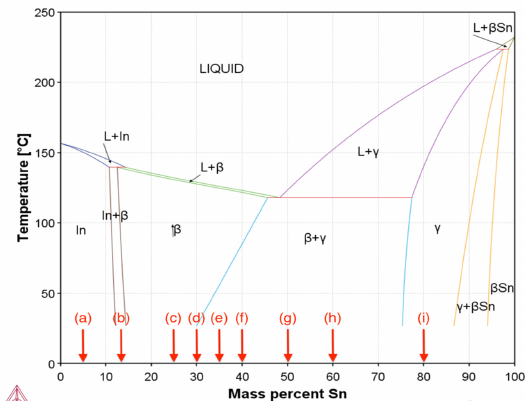
Figure 1. In-Sn binary phase diagram calculated based on Thermo-calc 2022a [22] database (TCSLD4: Solder Alloy v4.1) with binary alloy compositions studied in this work, the Sn content increases from (a) 5 wt% to (i) 80 wt% (pure Sn and In were investigated in addition to these com- positions).